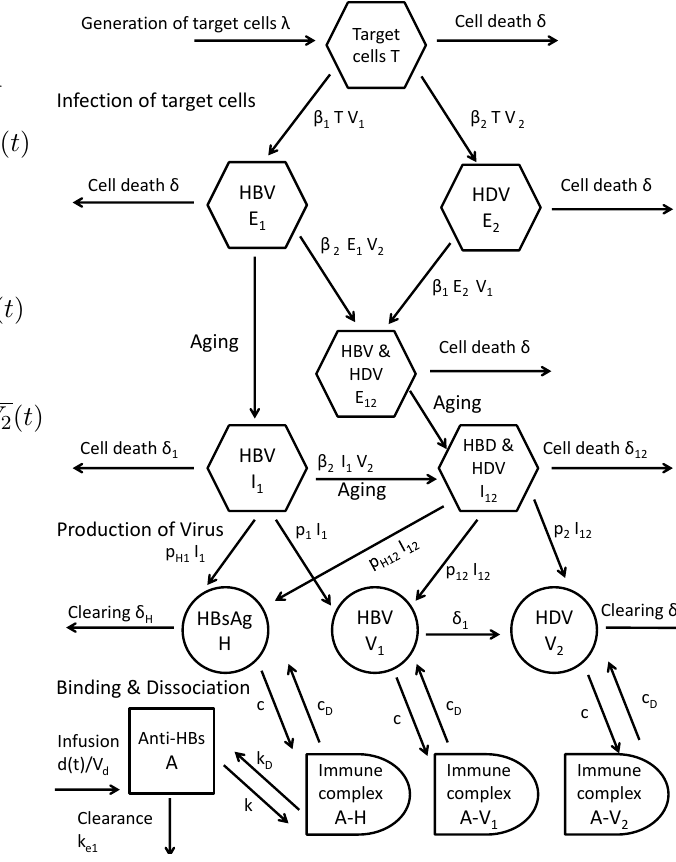
Fig. 1. The model of the main mechanism during treatment with anti-HBs after